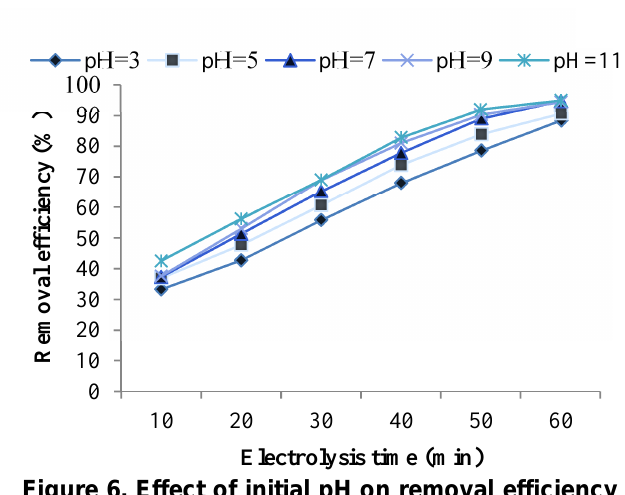
Figure 6. Effect of initial pH on removal efficiency of Reactive Green 19 (RG-19) dye (Voltage = 50 v, C 0 = 50 mg/l, d = 1 cm, KCl = 0.005 M, T = 22 ± 2 º C)